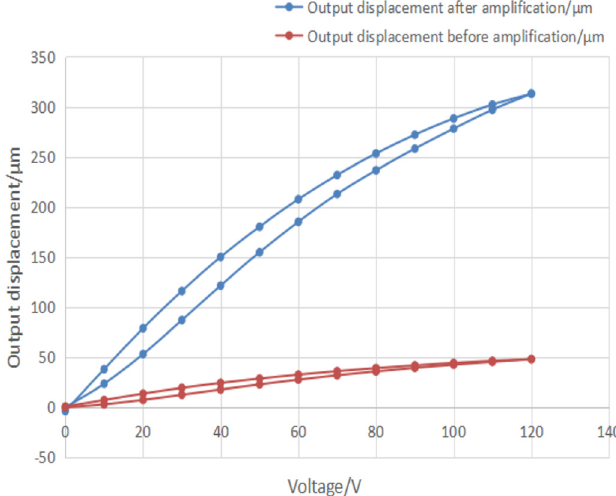
Fig. 13. Comparison of displacement output before and after ampli fi